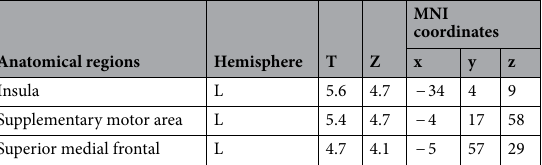
Anatomical regions Hemisphere